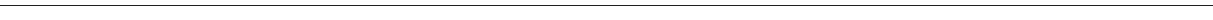
FIGURE 1 | western blot analysis using anti-His mouse antibodies. (B) Purified EspC protein (5 µ g/mL) was treated with or without proteinase K overnight at 56 ◦ C and was then subjected to western blot analysis using anti-His mouse antibodies. RAW264.7 cells were incubated with EspC (0.25, 1, 5, or 10 µ g/mL) and EspC (5 µ g/mL) treated with proteinase K, proteinase K alone, LPS (1 µ g/mL), LPS (1 µ g/mL) treated with proteinase K, or Pam3CSK4 (5 µ g/mL). After incubation for 24h, cell culture supernatants were collected, and TNF- α , IL-6, and MCP-1 levels were measured by ELISA. (C) THP-1 cells were differentiated in the presence of PMA for 48h and then incubated with EspC (5 µ g/mL) or LPS (1 µ g/mL). After incubation for 36h, cell culture supernatants were collected, and TNF- α , IL-6, and MCP-1 levels were measured by ELISA. (D) The expression levels of surface markers of RAW264.7 cells, including CD80, CD86, CD40, and MHC-II, were determined at 24h after treatment with medium alone, 5 µ g/mL EspC, or LPS by FACS analysis using respective FITC- or PE-conjugated monoclonal antibodies. (E) RAW264.7 cells were incubated with blocking antibodies before stimulation with EspC. TNF- α , IL-6, and MCP-1 production levels were measured by ELISA. All data are expressed as means ± SEMs ( n = 3); * p < 0.05, ** p < 0.01, *** p < 0.001.